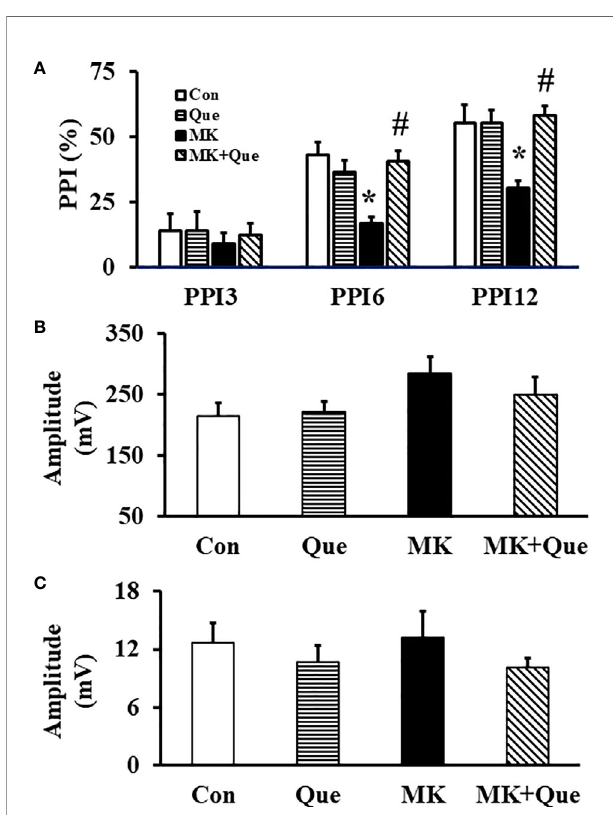
FIGURE 3 | prepulse inhibition (PPI) (A) , auditory startle respone to the startle stimulation (B) and auditory response of the no-stimulus (C) in a PPI test in the mice of control (Con), quetiapine (Que), MK-801 (MK), and MK-801 +quetiapine (MK+Que) groups. Quetiapine prevented the decrease of the PPI (%) in the MK-801 mice at PPI6 and PPI12, and quetiapine and MK-801 had no effects on the PPI (%) at PPI3, on the auditory startle respone to the startle stimulation and on the auditory response of the no-stimulus. n=10 in each group. Mice were treated with chronic quetiapine (10 mg/kg/day, intraperitoneally) for 28 days. From day 22 to 28, 1 h after the administration of quetiapine, the mice were administered MK-801 (2 mg/kg/day, subcutaneously). On day 31, the sensorimotor gating in mice was evaluated in a PPI test. Results are expressed as means ± S.E.M. * P < 0.05 vs. Con, # P < 0.05 vs.